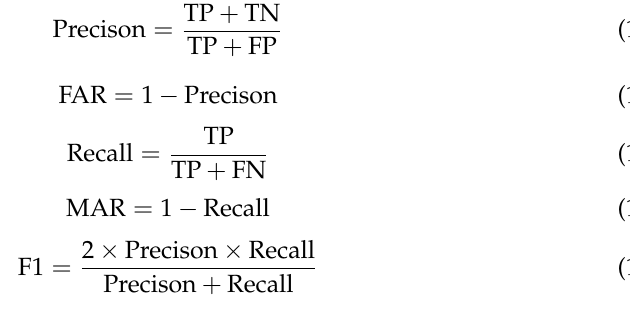
Table 2. Evaluation indexes of classification